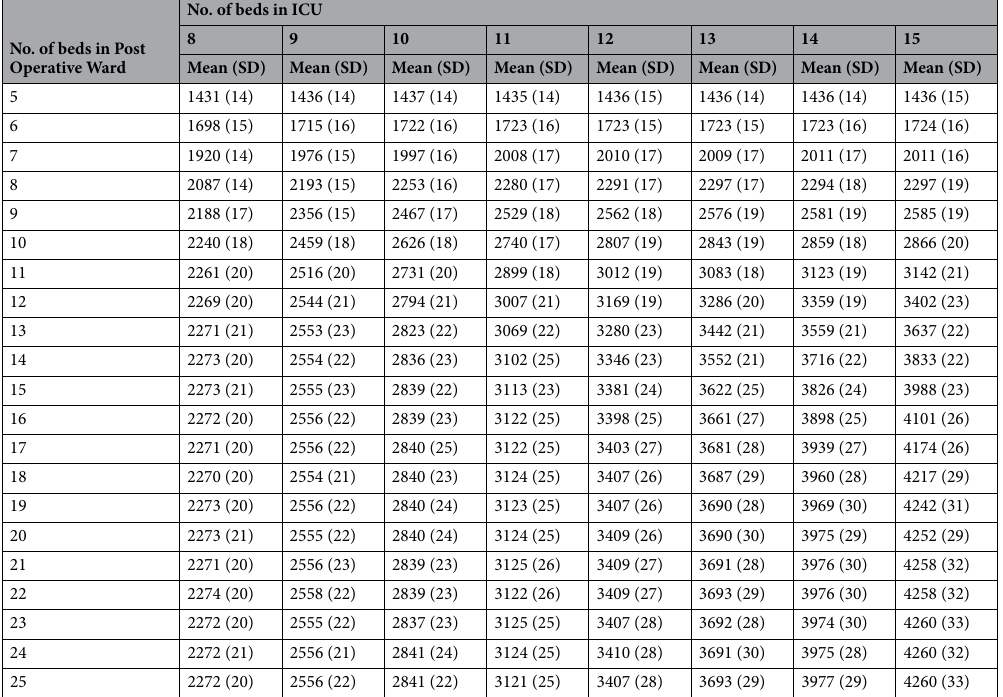
Table 2. The throughput of patients during 800 days for different number of beds in ICU and post operative ward (POW). SD standard deviation.